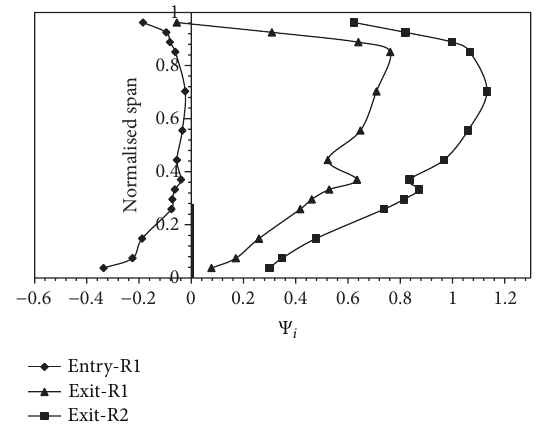
Figure 9: Spanwise total pressure coefficient along the stage at design speed